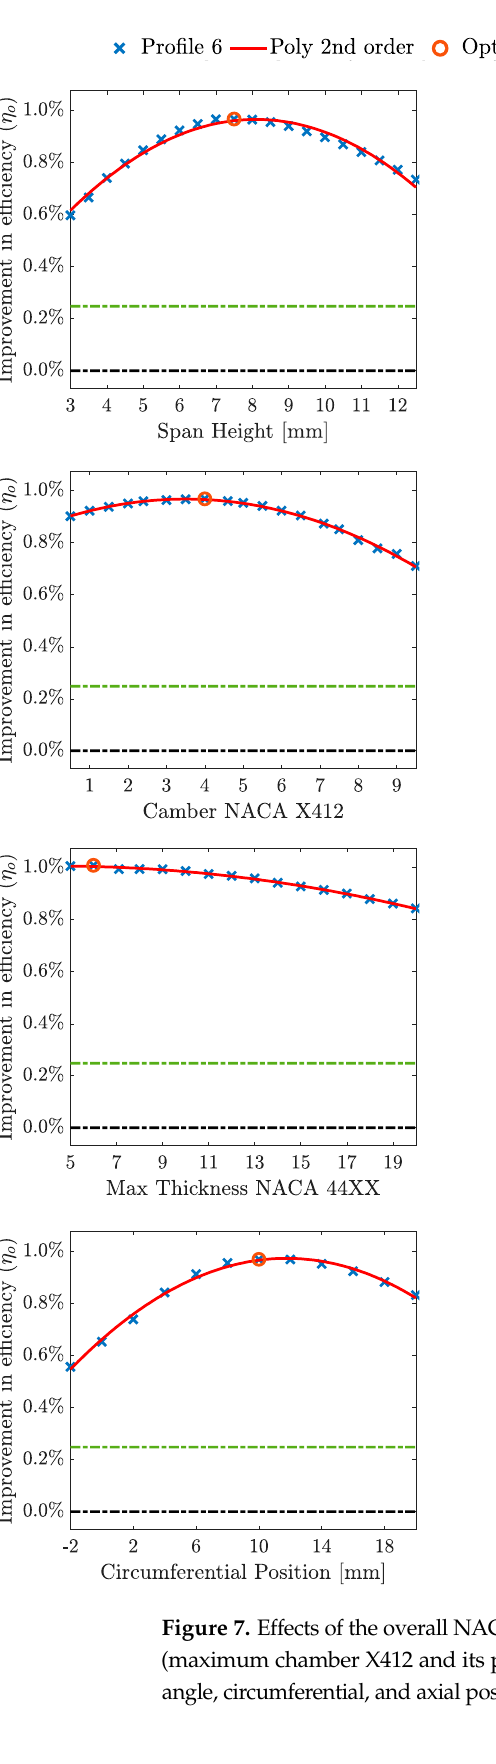
cent chord. Thus, 4412 has a maximum camber of 4% of the chord located at 40% chord from the leading edge and has a maximum thickness of 12% of the chord.